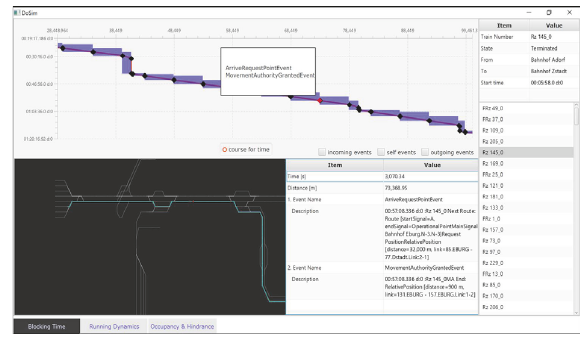
Figure 3: Screenshot of tracing events and train